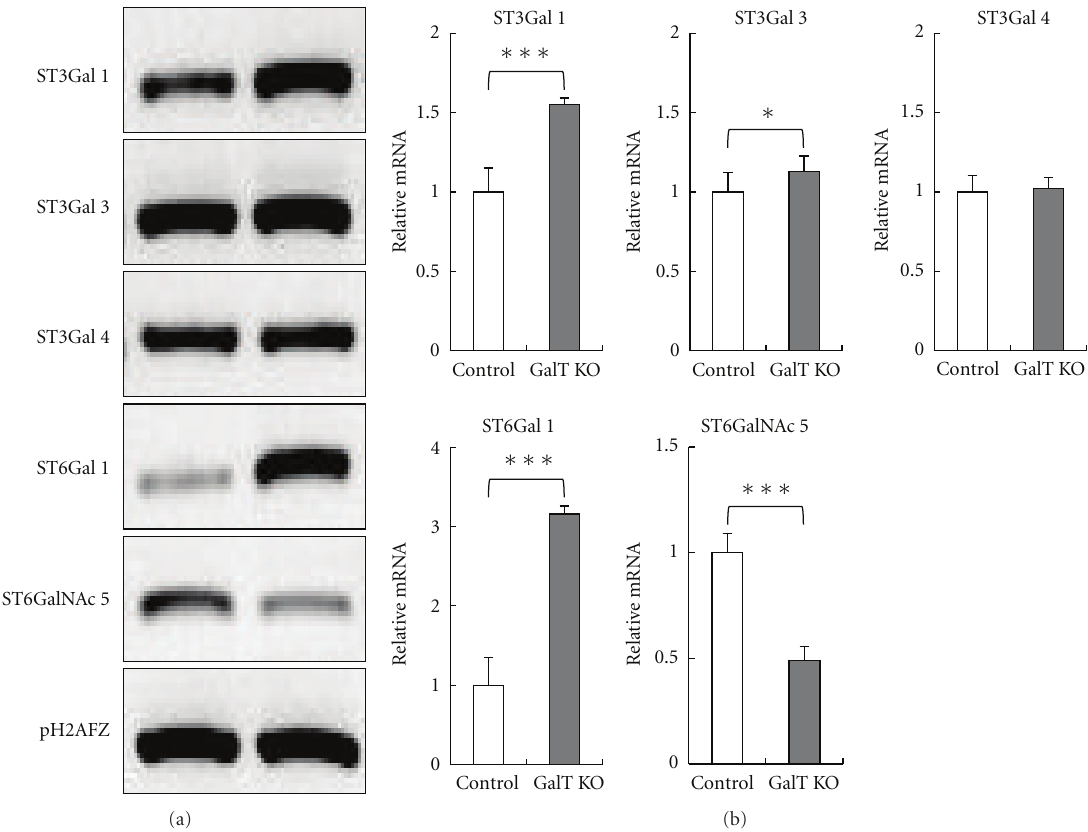
Figure 1: Expression of sialyltransferases in control and heterozygote α 1,3-galactosyltransferase gene (GGTA1) knockout (GalT KO) liver. (a) Electrophoretic analysis of real-time reverse transcriptase-polymerase chain reaction (RT-PCR) in control and heterozygote GalT KO liver. (b) Quantification of real-time RT-PCR analysis in control and heterozygote GalT KO liver. All RT-PCR reactions were conducted in triplicate and normalized with pig H2A histone family, member Z gene (pH2AFZ). Each of the GalT KO relative values is presented as an n-fold expression di ff erence compared to the control, which was set as 1. ∗ P < 0 . 05, ∗∗∗ P < 0 . 001.